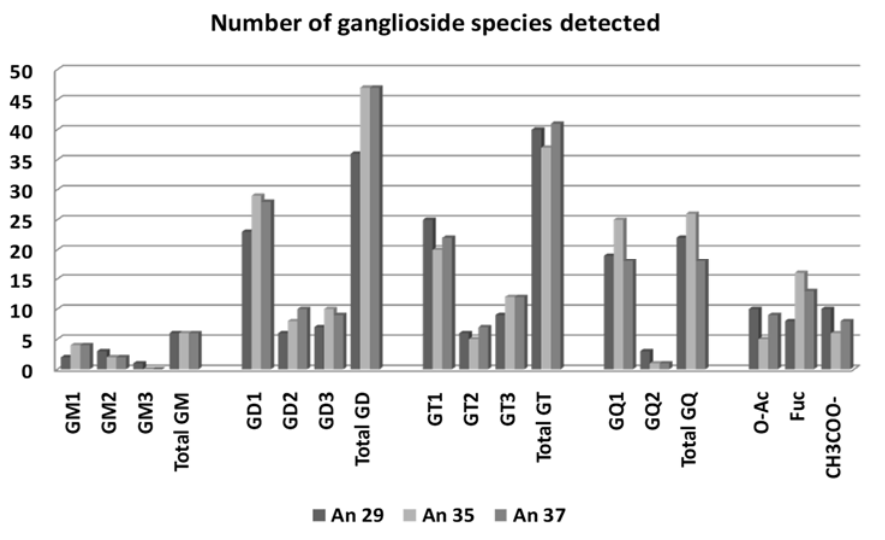
Figure 2. Histogram plotting the number of the identified species in An29, An35, and An37, according to the composition of their glycan core (reprinted with permission from [138]).